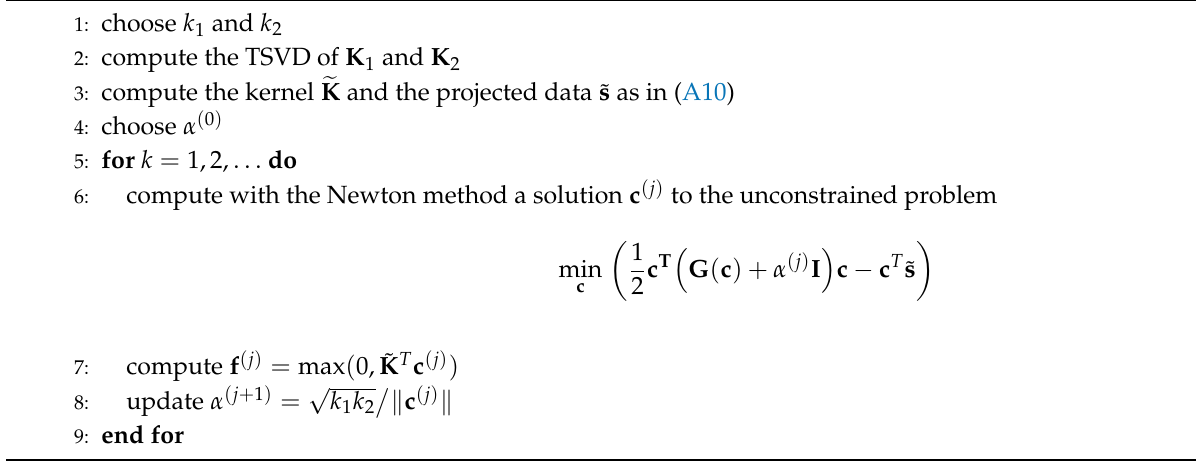
Algorithm A2: VSH (Venkataramanan–Song–Hürlimann)